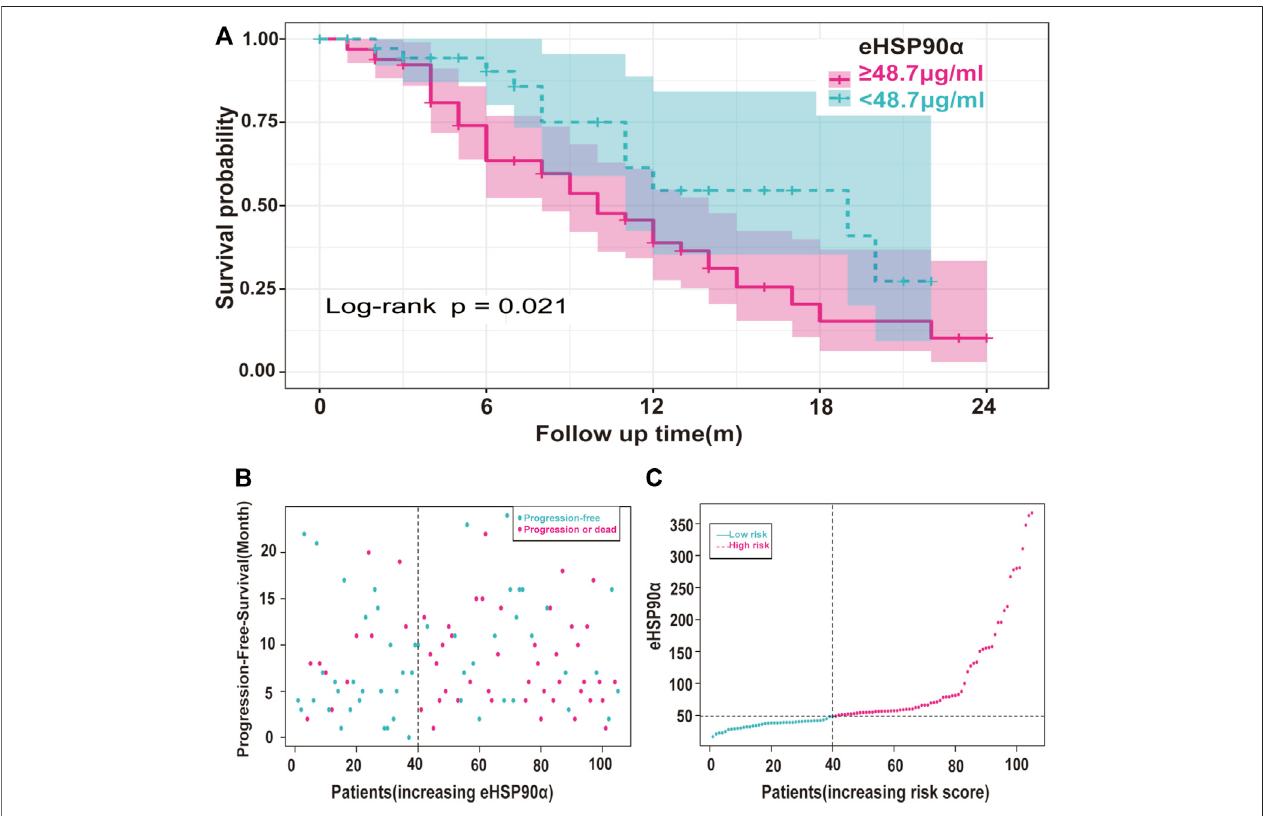
FIGURE6| RiskAnalysisofeHSP90 α andprogressioninSCLC (A) Kaplan-MeiercurvesoftheSCLCpatientsweredividedintotwogroupswith48.7 ng/mLasthe cut-off value (B) Scatter plots of risk score and time to progression were constructed using the survival time model and divided according to the results shown red for progression and blue for survival (C) A risk pro fi le was created using a survival time model to rank patients from low to high risk. The ordinate is the expression of eHSP90 α , and the dotted line is the median value, distinguishing high and low risks: red means high risk, and blue means low risk.